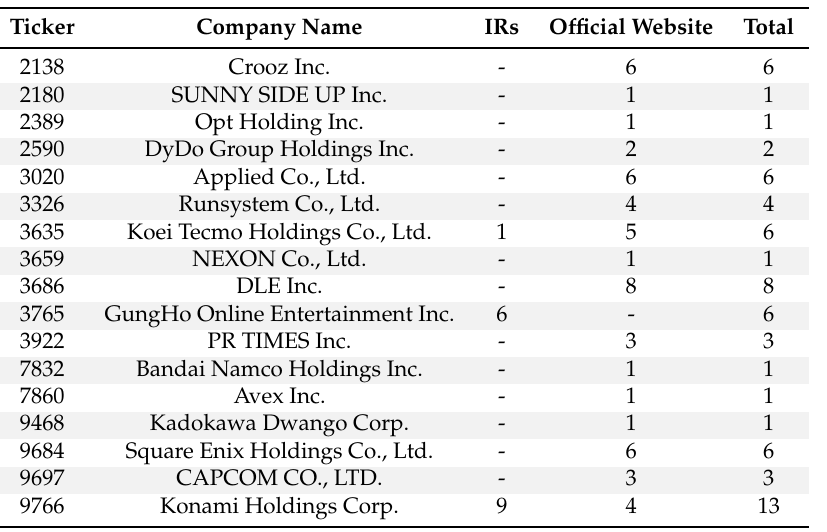
Kadokawa Dwango Corp. Square Enix Holdings Co., Ltd. - 9697 CAPCOM CO., LTD. - 9766 Konami Holdings Corp.